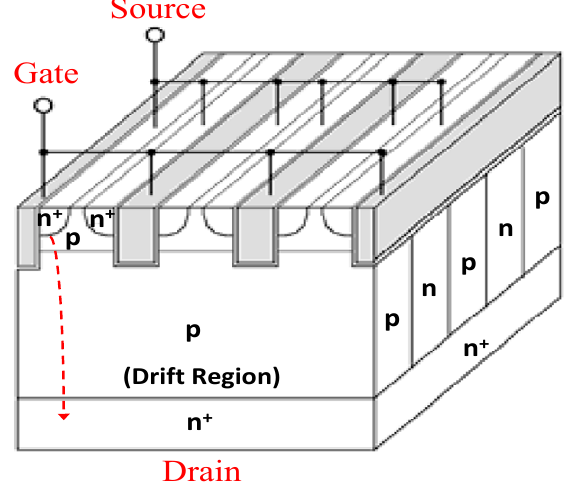
Figure 1. Vertical DMOS with an SJ (super-junction) structure in the drain side.